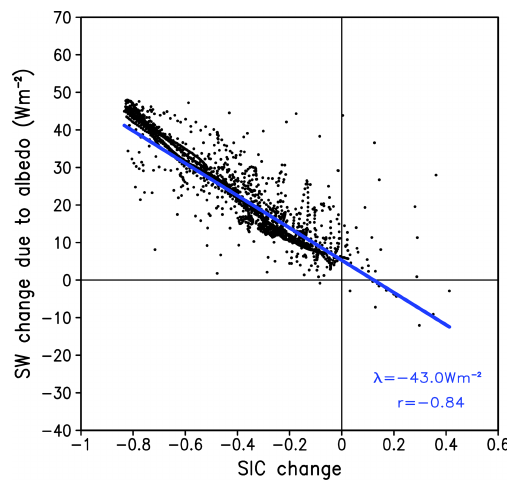
Figure 5. The annual mean net shortwave flux change (Wm − 2 , positive downward) caused by the albedo effect of sea ice change averaged over the Arctic Ocean as a function of SIC change. All the change is with respect to the pre-industrial period, and each dot represents one grid point value over the Arctic